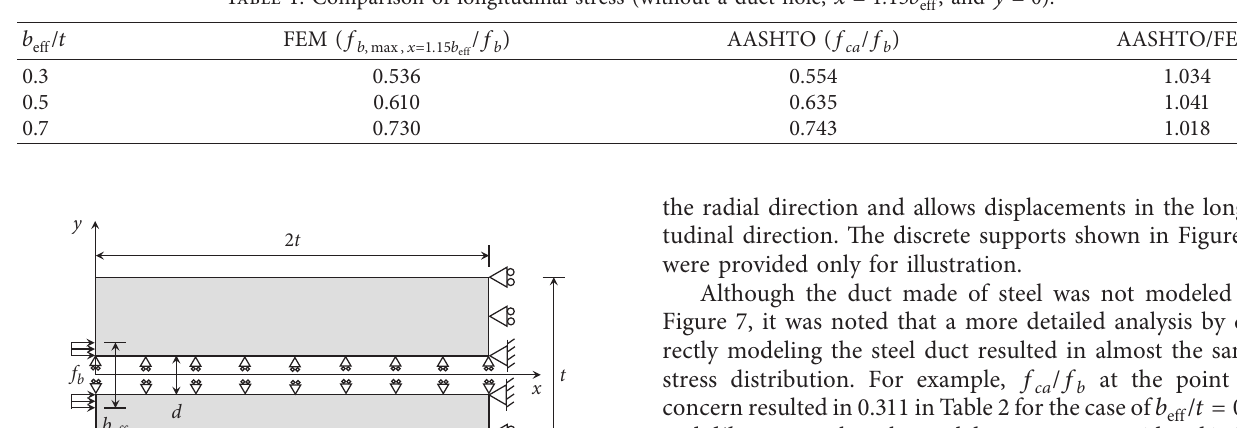
Figure 6: Contour of longitudinal stress (without a duct hole and b Table 1: Comparison of longitudinal stress (without a duct hole, x � 1 . 15 b